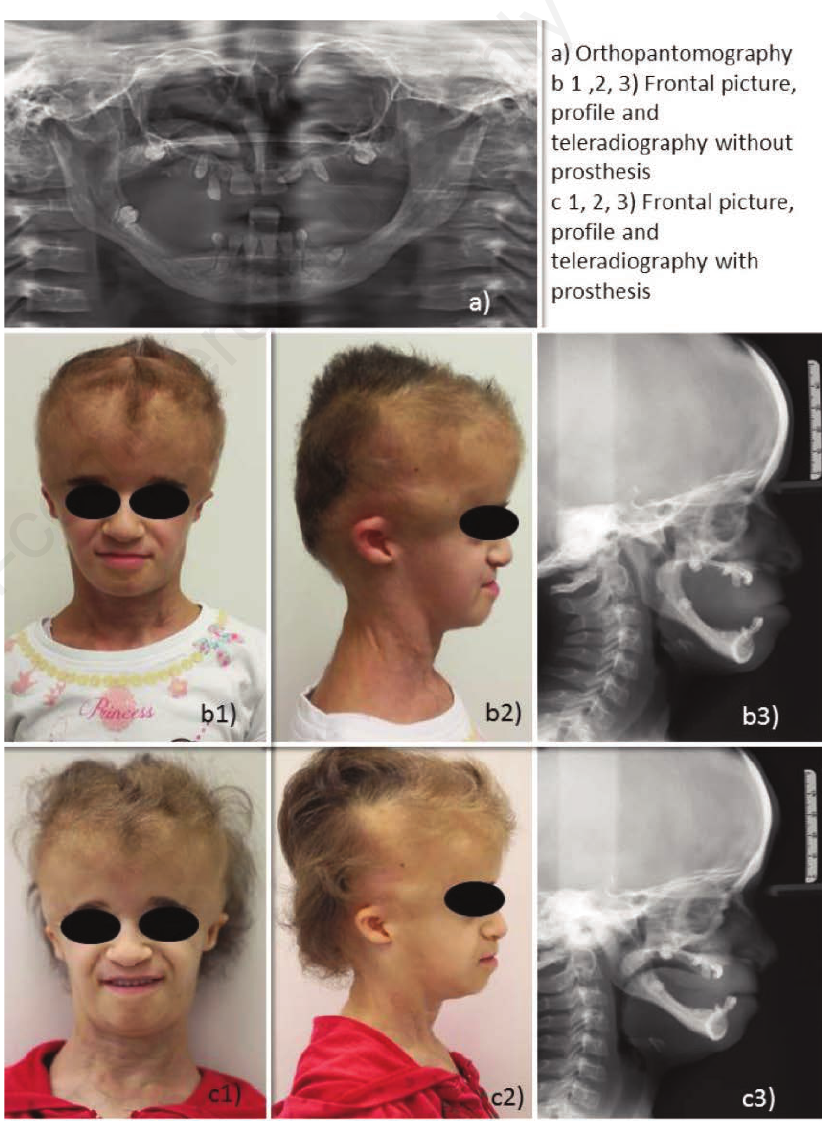
Figure 1. X-rays and pictures before and after the oral